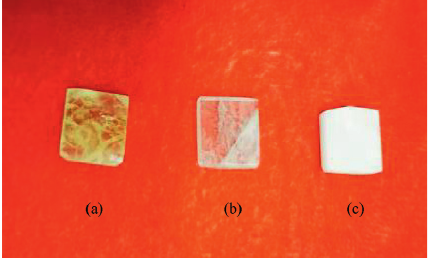
Figure 2: The surface of minerals: (a) scheelite, (b) fluorite, and (c) calcite.